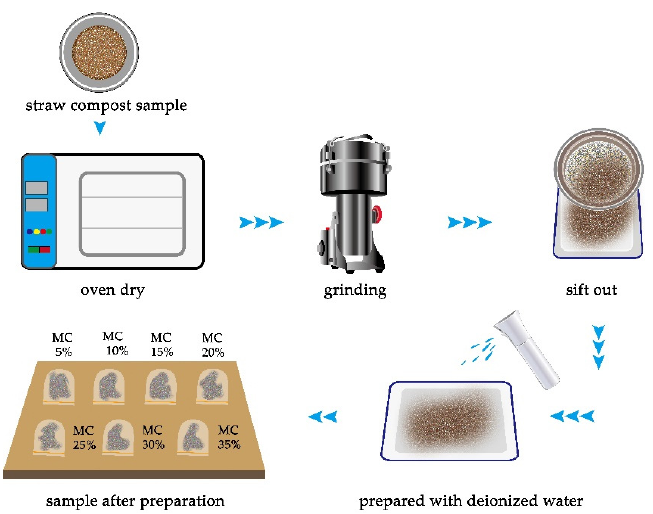
Figure 1. Preparation of straw compost samples with various moisture